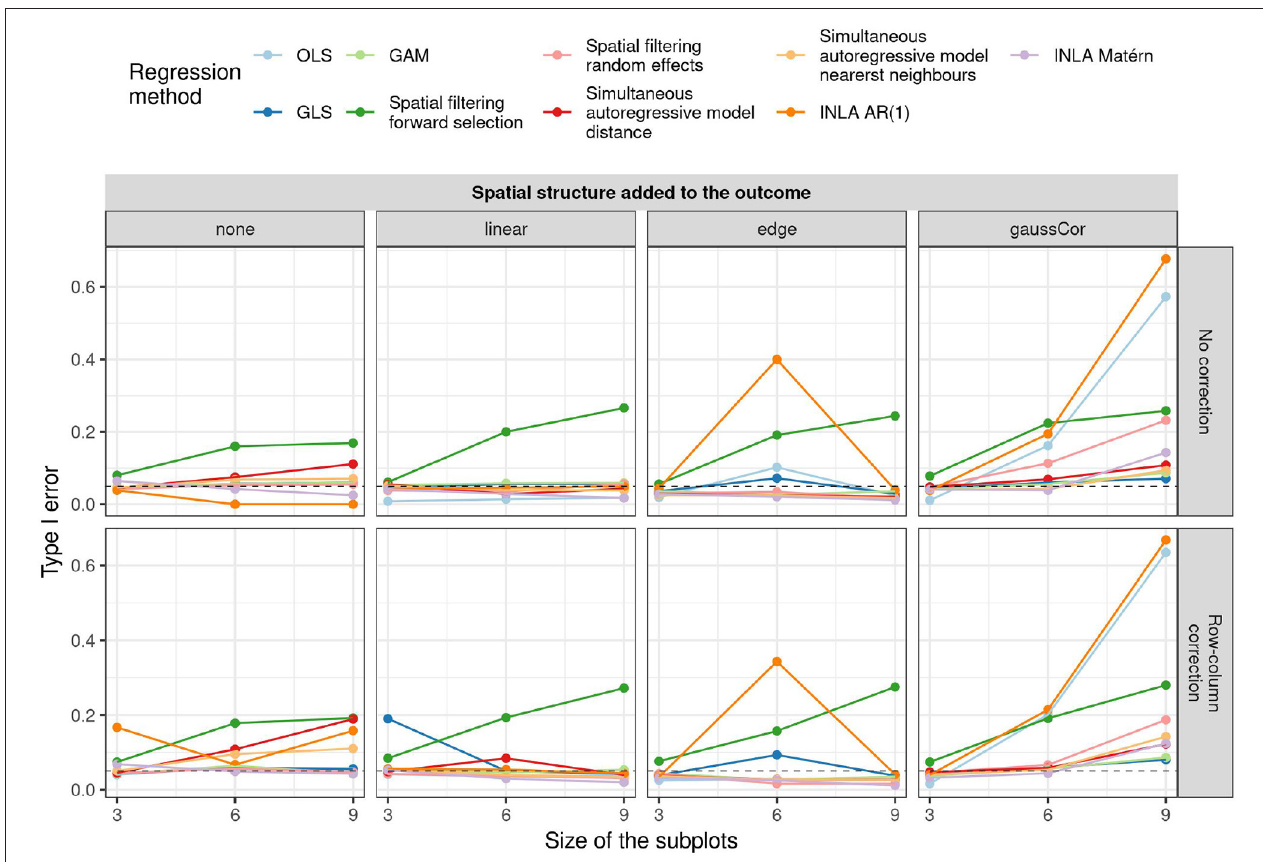
FIGURE 3 | Type I error for the univariate scenario with checkerboard design for different regression methods (colors) for different spatial structures of the outcome (columns) and size of the subplots (x-axis) as a function of whether or not row and column correction was applied (rows). The dashed horizontal line indicates the 5% significance